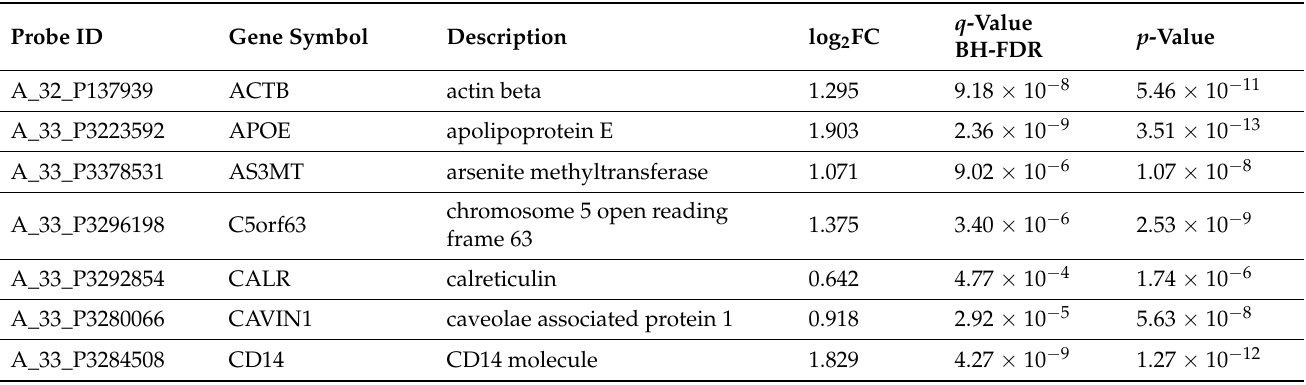
Table 2. Upregulated genes, as resulted from the statistical comparison of melanoma vs. healthy samples (One Class Rank Product). Positive log 2 FC values indicate overexpression in the tumour compared to healthy